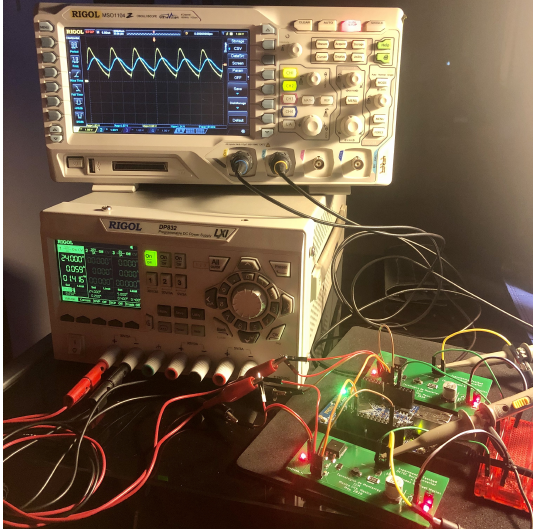
Figure 21. Simultaneous current evaluation of the experimental testbeds.